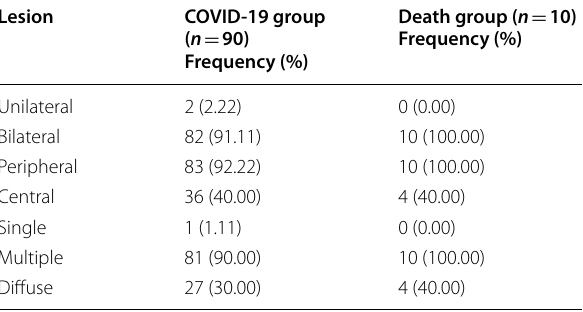
Table 3 Frequency distribution of affected parts of the lung in coronavirus patients and deceased